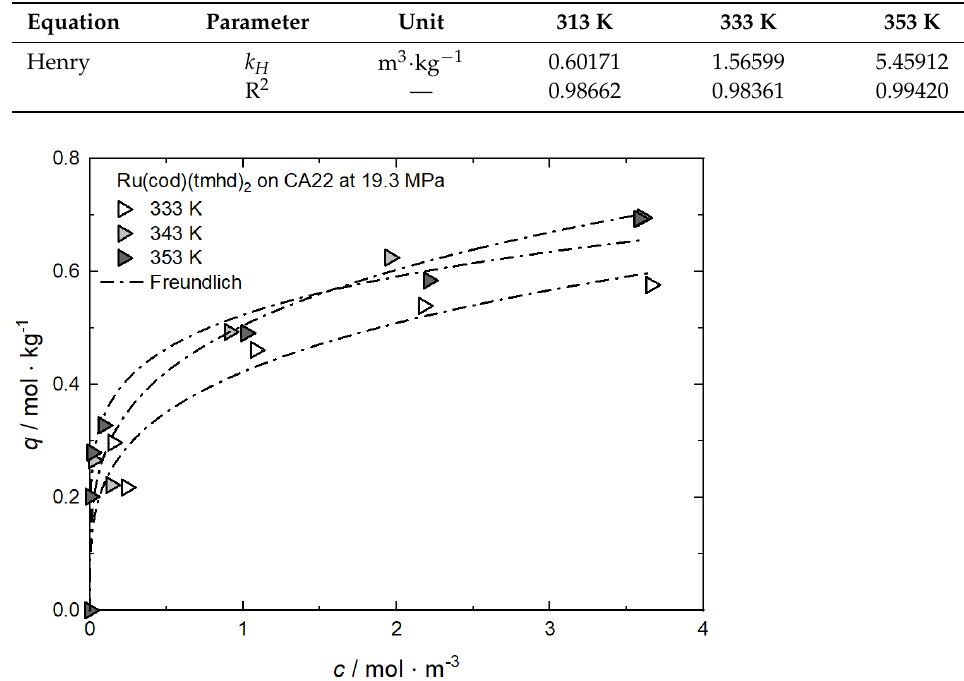
Figure A8. Uptake of Rh(acac) 3 on MCM-41 at 15 MPa and different temperatures; experimental data taken from [62]. Table A8. Adsorption isotherm parameters for Rh(acac) 3 from scCO 2 solution on MCM-41 at 15 MPa and different temperatures [62].